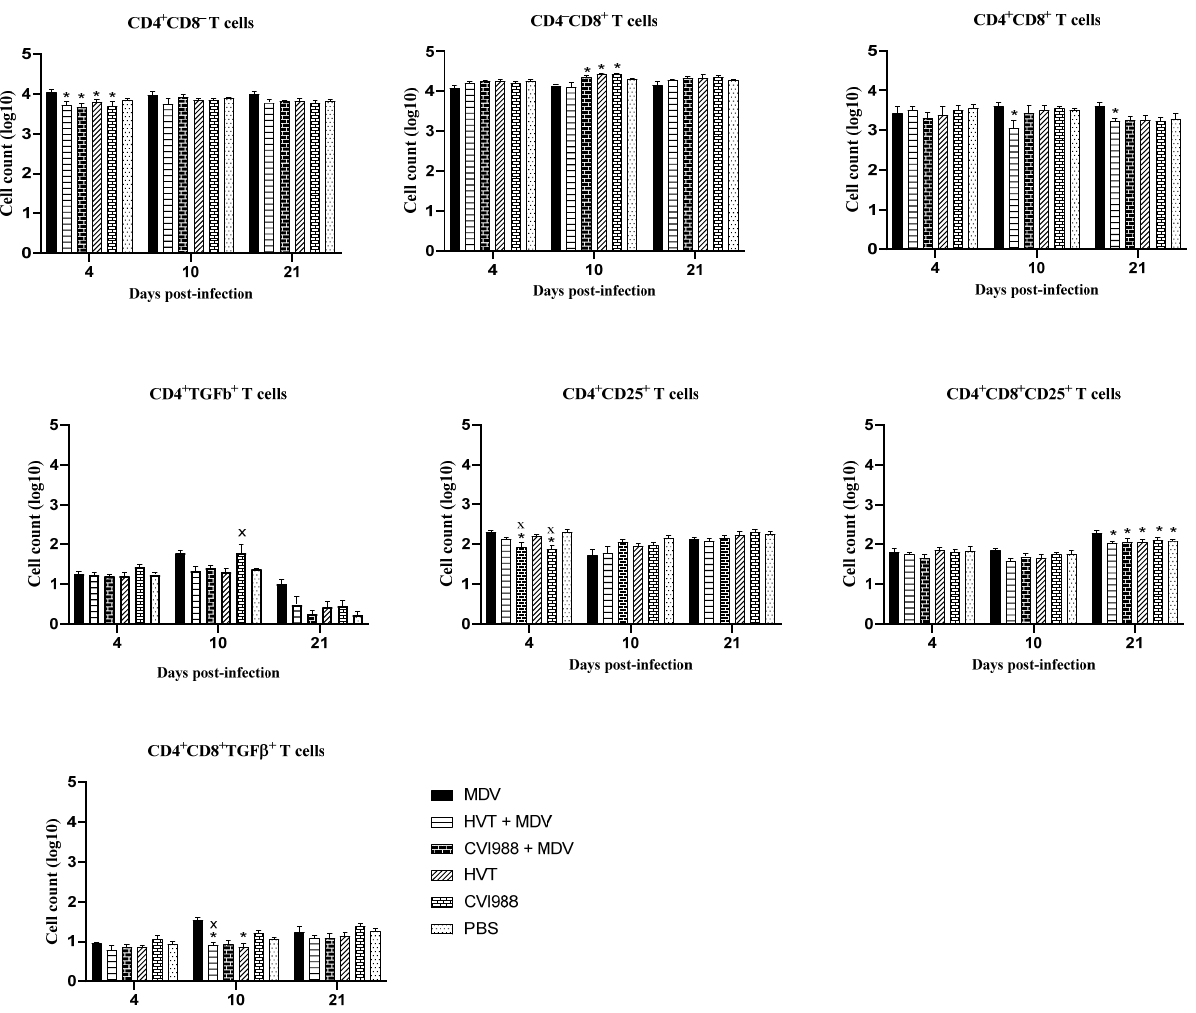
Figure 3. Evaluation of T cell subsets in the spleen (n = 6) at 4, 10, and 21 dpi. Spleen cells were analyzed by flow cytometry at different time points following the MDV challenge. Two-way ANOVA and Tukey’s multiple comparison test were used to analyze these data. If p -value was ≤ 0.05, it was considered statistically significant when compared with PBS (x) or MDV (*). Cell counts on the Y -axis are presented on a logarithmic scale. Error bars indicate mean ± standard error of mean.